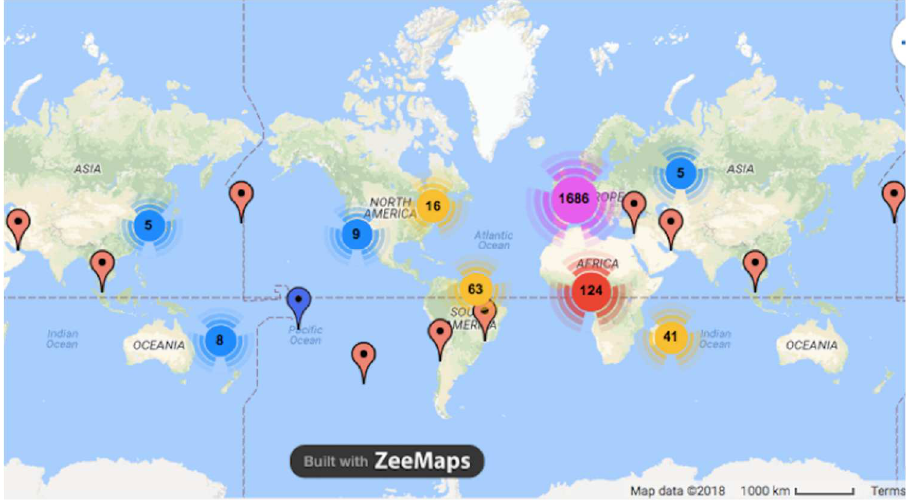
Figure 1. Distribution des inscrits à l’échelle internationale.